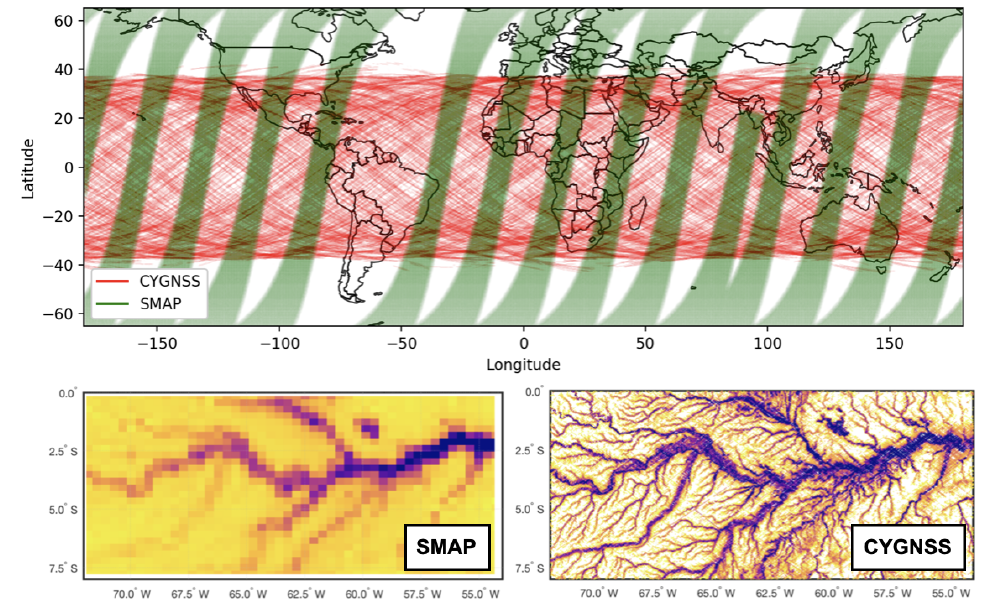
Figure 1. Comparison of SMAP and CYGNSS daily coverage ( top ) and attainable spatial resolutions ( bottom